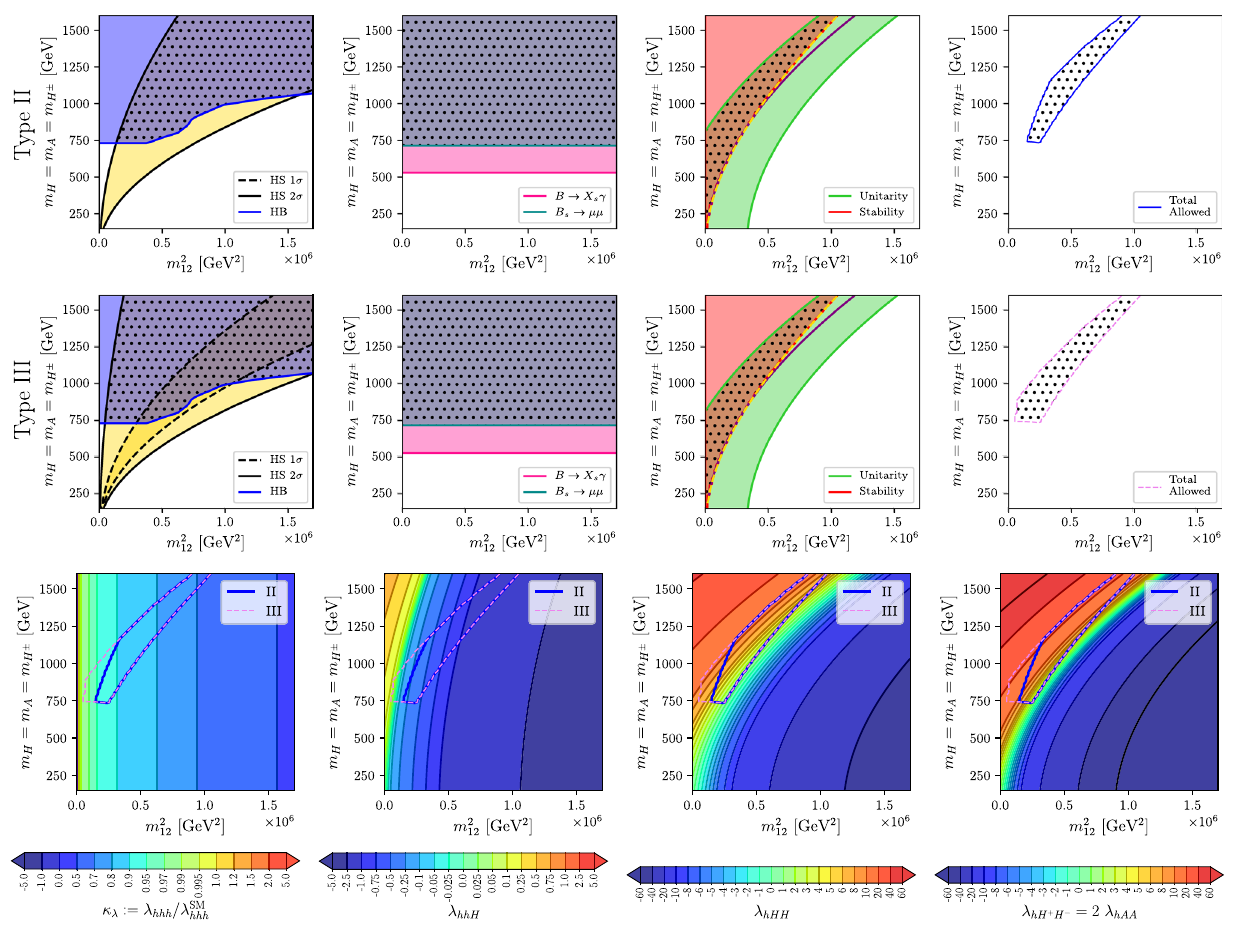
Fig. 9 Allowed areas (dotted regions) from the various constraints in type II (upper row) and type III (middle row) and triple Higgs couplings (lower row) for the benchmark scenario II/III-2 in the m 2 – m plane with tan β = 1 . 2 and c β − α = − 0 . 12